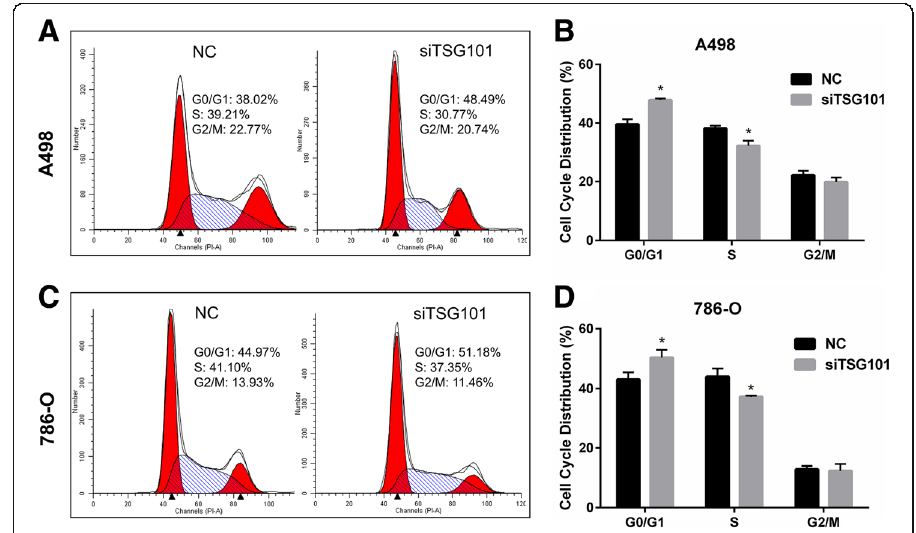
Fig. 3 TSG101 downregulation induced RCC cell cycle arrest. Flow cytometry in ( a ) A498 and ( c ) 786-O cells transfected with siTSG101 or NC. b and d The G0/G1, S, and G2/M phase proportions of A498 and 786-O cells transfected with siTSG101 or NC. Data are presented as means ± SD. * p <0.05 vs. control group